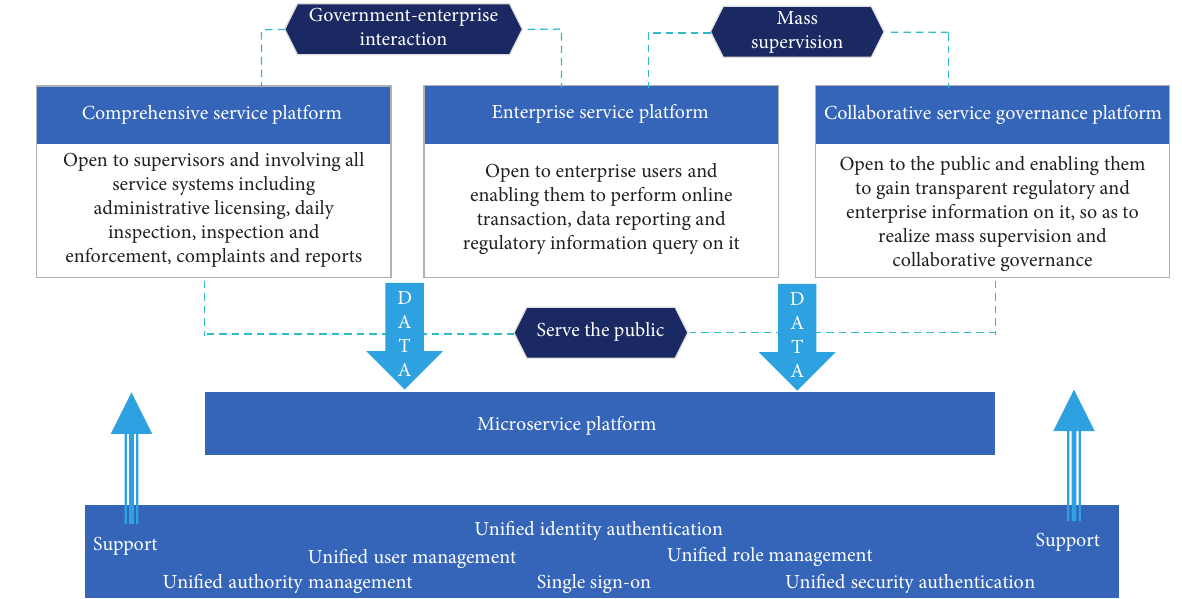
Figure 6: Service framework of the provincial food and drug regulatory